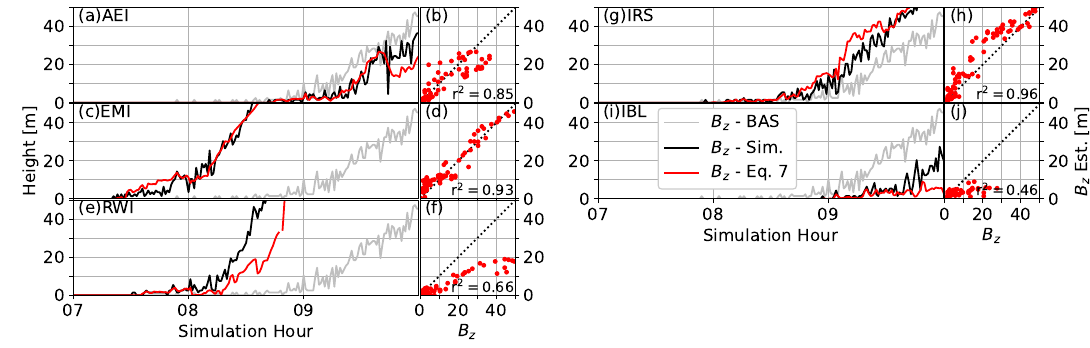
Figure 9. The simulated and estimated locations of the lower interface, B z , for each of the six simulations in Table A2. ( a , c , e , g , i ) Time series of estimated and simulated B z compared to B z from the BAS simulation (Figure 7a). ( b , d , f , h , j ) 1:1 comparison of estimated B z to simulated B z (as in Figure